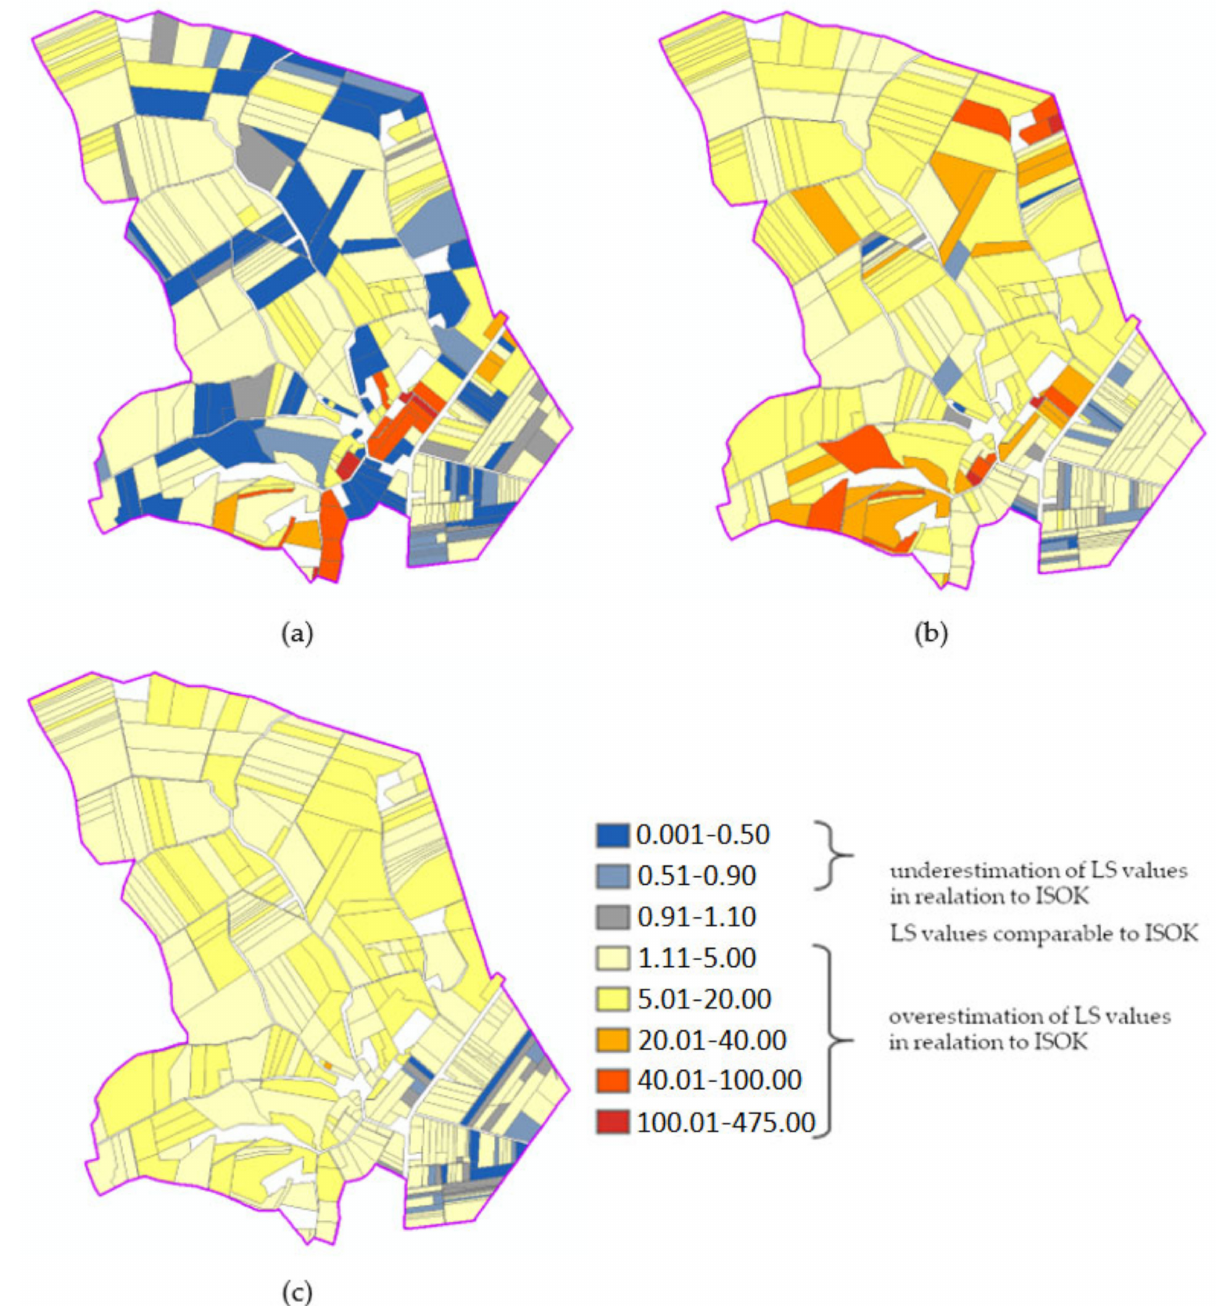
Figure A6. Comparison of the values of the variability index Wz for the sum of the total LS factor values in the plots used for agriculture obtained from the DTM SRTM ( a ), DTED2 ( b ) and LPIS ( c ) against ISOK for the Winiarki research